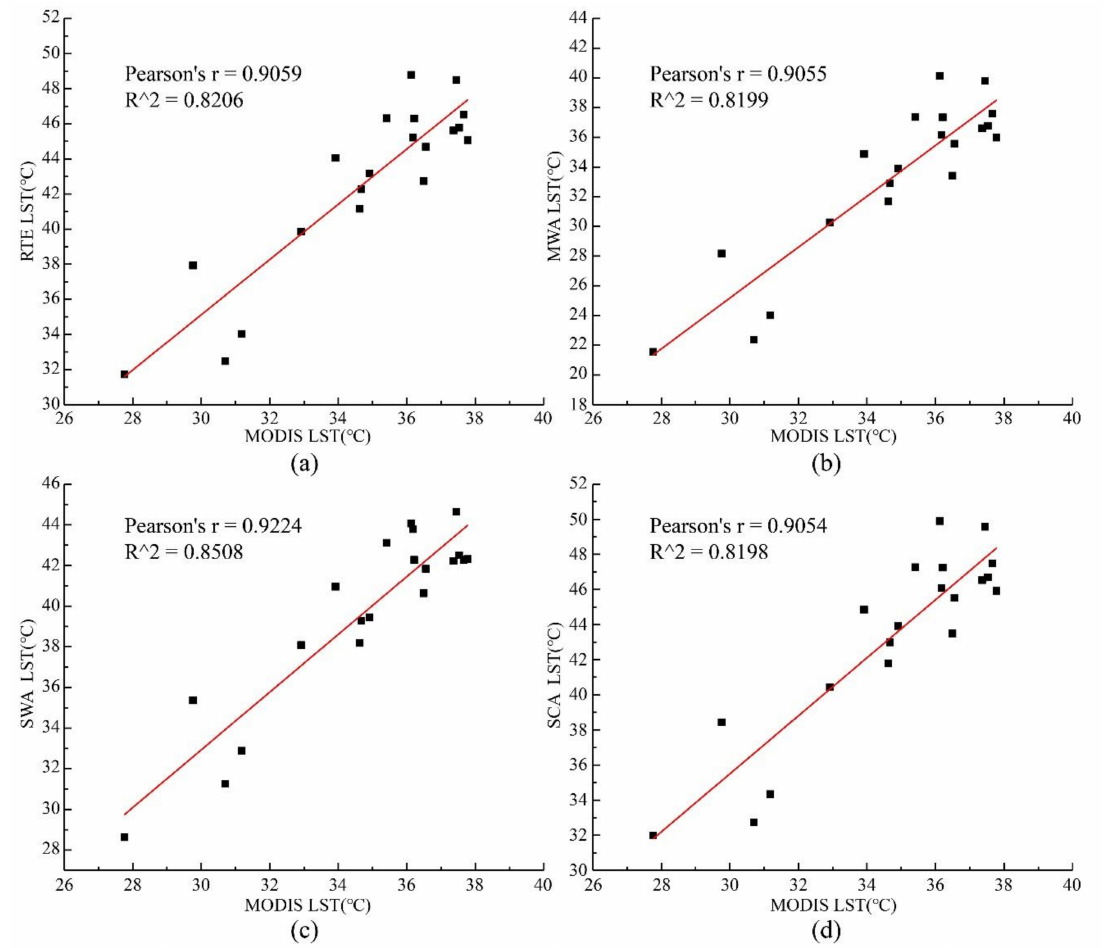
Figure 7. Comparison of land surface temperatures retrieved from Landsat-8 using four different algorithms with the MOD11A2 temperature product on 16 August 2020. ( a ) is the RTE; ( b ) is the MWA; ( c ) is the SWA; ( d ) is the